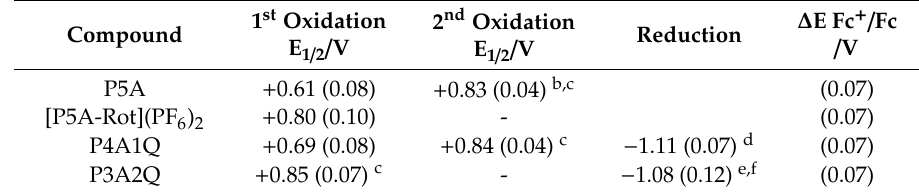
a CH 2 Cl 2 containing [NBu 4 ][BF 4 ] (0.4 M) as supporting electrolyte, at ambient temperature. Potentials quoted at 0.10 Vs − 1 against E 1 / 2 Fc + / Fc used as the internal standard. Values in brackets are ∆ E ( = E pa – E pc ); b unresolved process between these oxidations; c shows significant scan rate dependence d second reduction at E pc − 1.72 V; e centre of two overlapping processes; f additional reduction at E pc − 1.72 V.